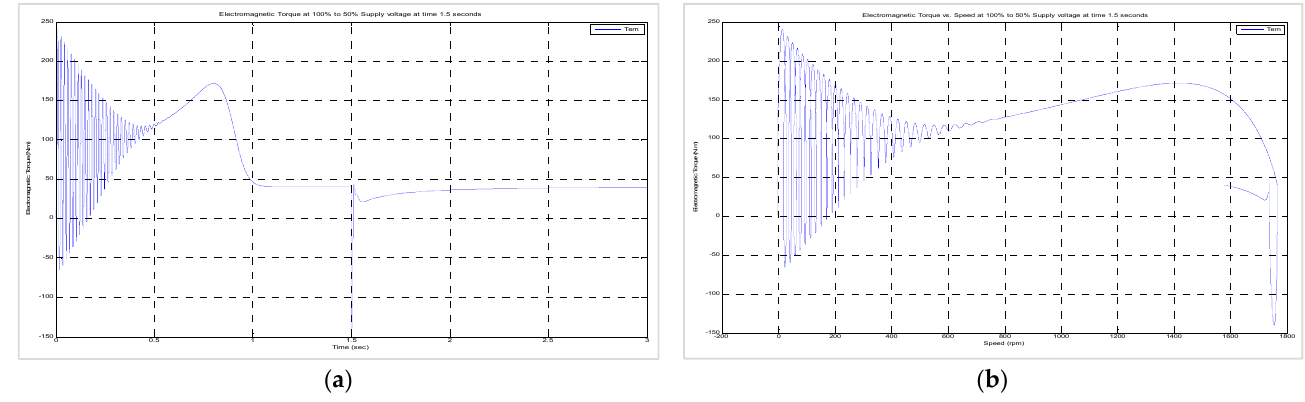
Figure 25. ( a ) The change in the voltage supply from 100% to 50% at 1.5 s. ( b ) Line current when the voltage changes from 100% to 50% at 1.5 s.